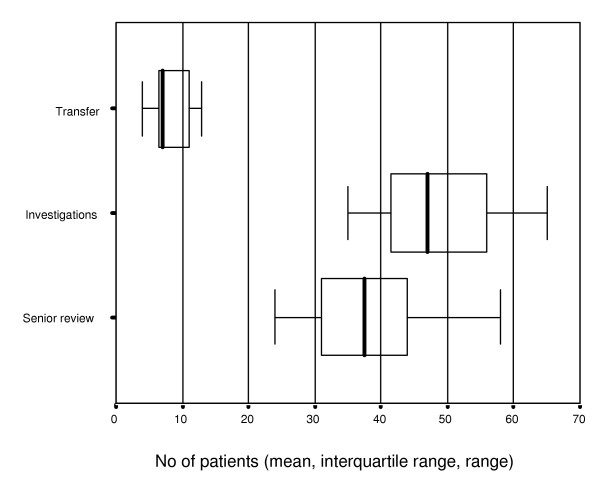
Numbers of potential discharges.